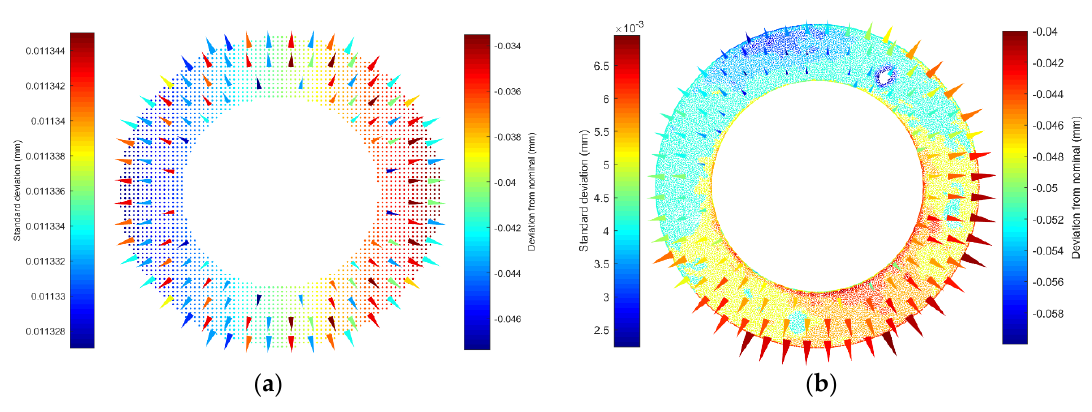
Figure 16. Visualization of variation and standard deviation for feature C. Points colored based on deviations from nominal, and cone size and color varied based on standard deviation. ( a ) A sample of predicted SMS; ( b ) a sample of scanned data points.